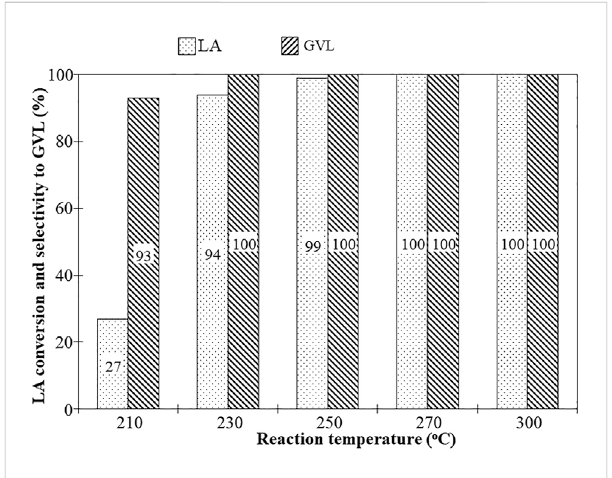
FIGURE 3 In fl uence of reaction tempreature on LA conversion and GVL selectivity. Reaction conditions: Catalyst-MgO-UBE, LA:FA weight ratio-1:2, liquid fl ow-0.015 mL/min, N2 fl ow-25 cc/min, catalyst weight-0.5